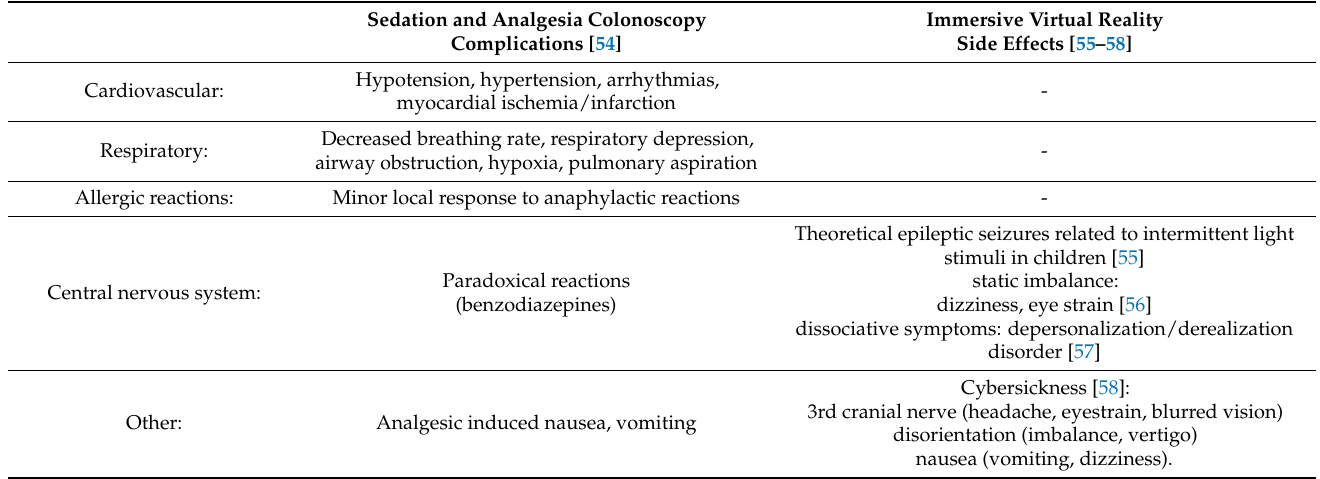
Table 4. Comparison of side effects of sedation colonoscopy vs. iVR exposure complications. Sedation and Analgesia Colonoscopy Complications